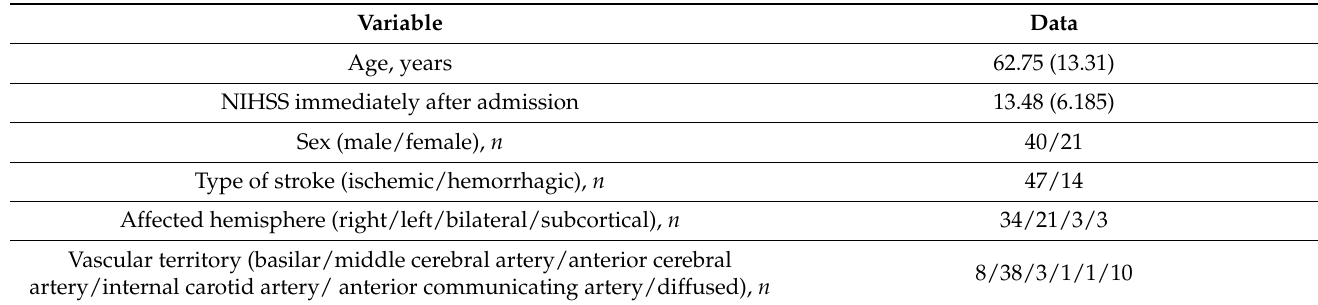
Table 2. Characteristics of the study sample ( n = 61).